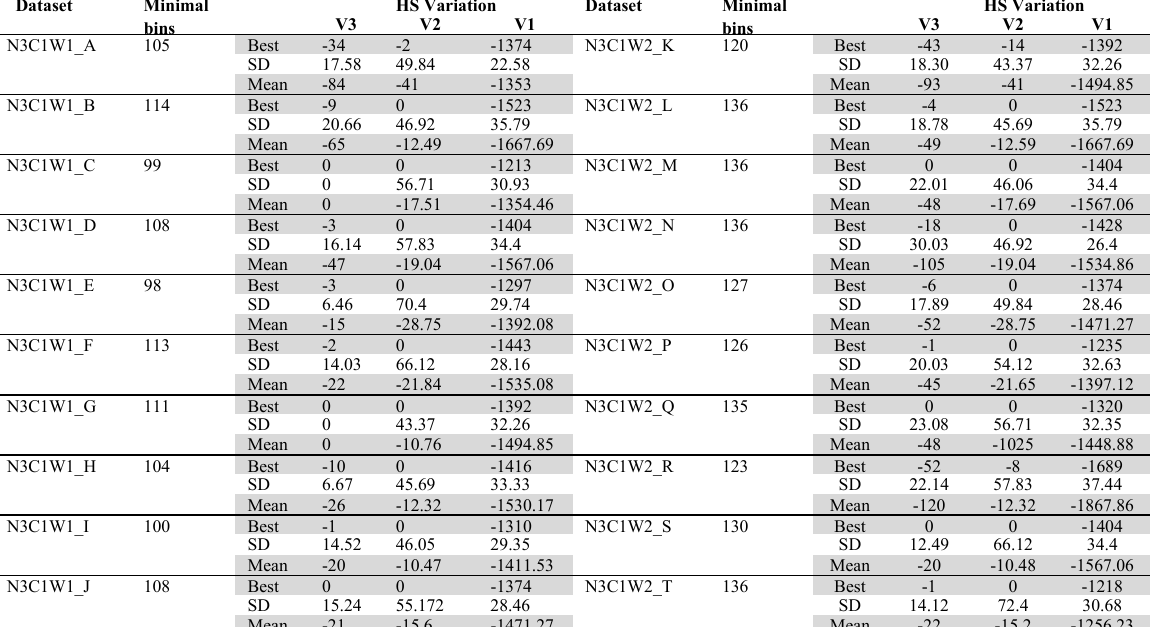
Best, mean and standard deviation values of proposed HS variations for 60 datasets with 200 objects Dataset Minimal HS Variation bins